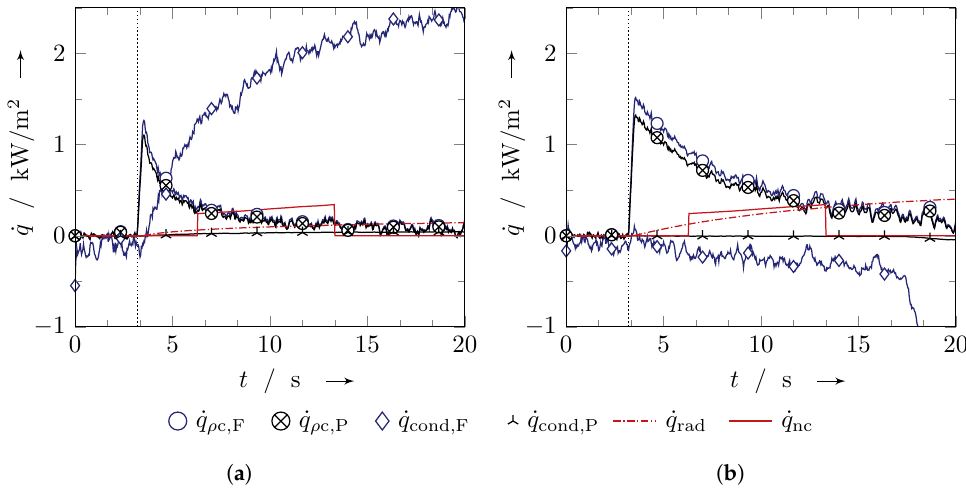
Figure 4. Transient results for the individual terms of specific heat flux in Equation (2): ( a ) Pixel in stagnation point; ( b ) Pixel 7 D from stagnation